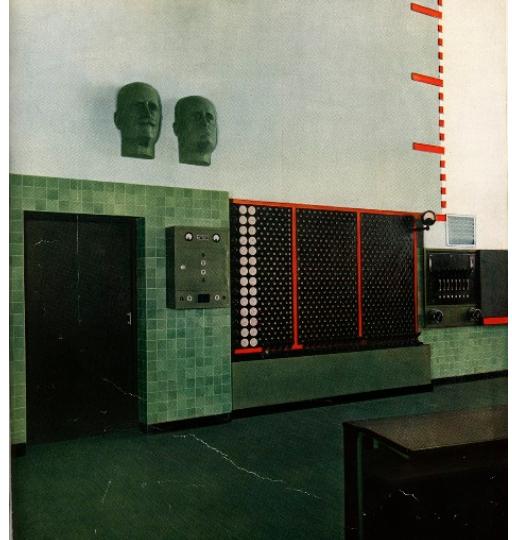
Figure 39. The Superior and Experimental Physics graduated classroom. Photo from (De Smaele 1936, p. 21).